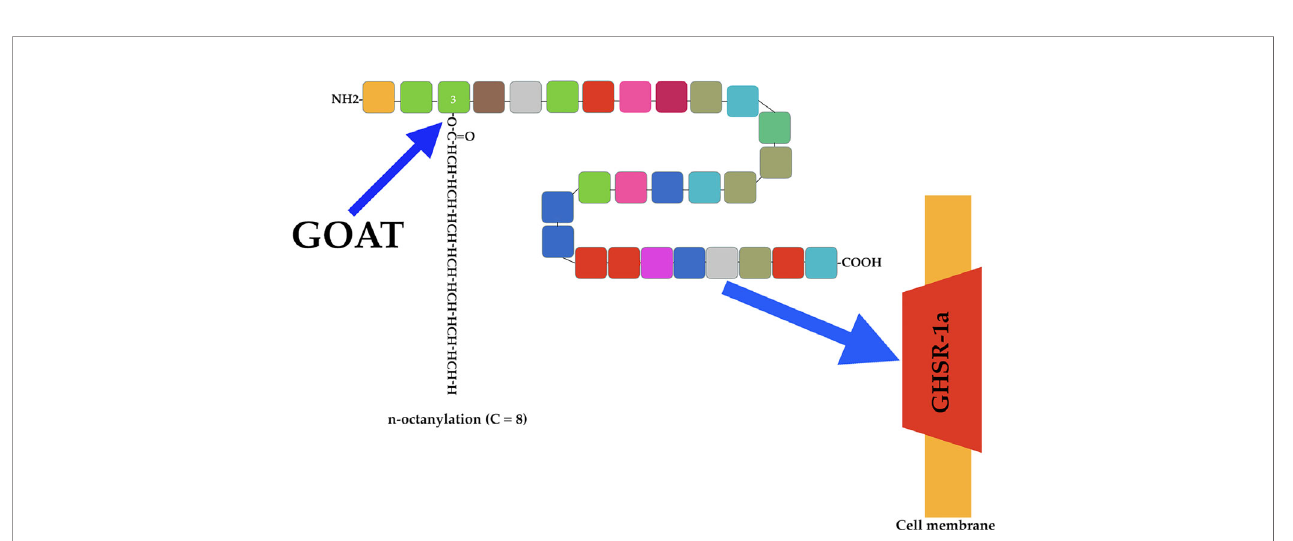
FIGURE 2 | Ghrelin acylation and ghrelin receptor. The endocrine active form of ghrelin is produced by attaching an n-octanoyl group (usually 8 C) to serine at position 3 of the ghrelin molecule (blue arrow). This is done by the enzyme ghrelin-O-acyl-transferase (GOAT). Active acyl ghrelin acts on a receptor (blue arrow) expressed mainly in the pituitary and hypothalamus. This receptor is a G-protein-coupled receptor (GHSR-1a), and cannot be activated by des-acyl ghrelin.